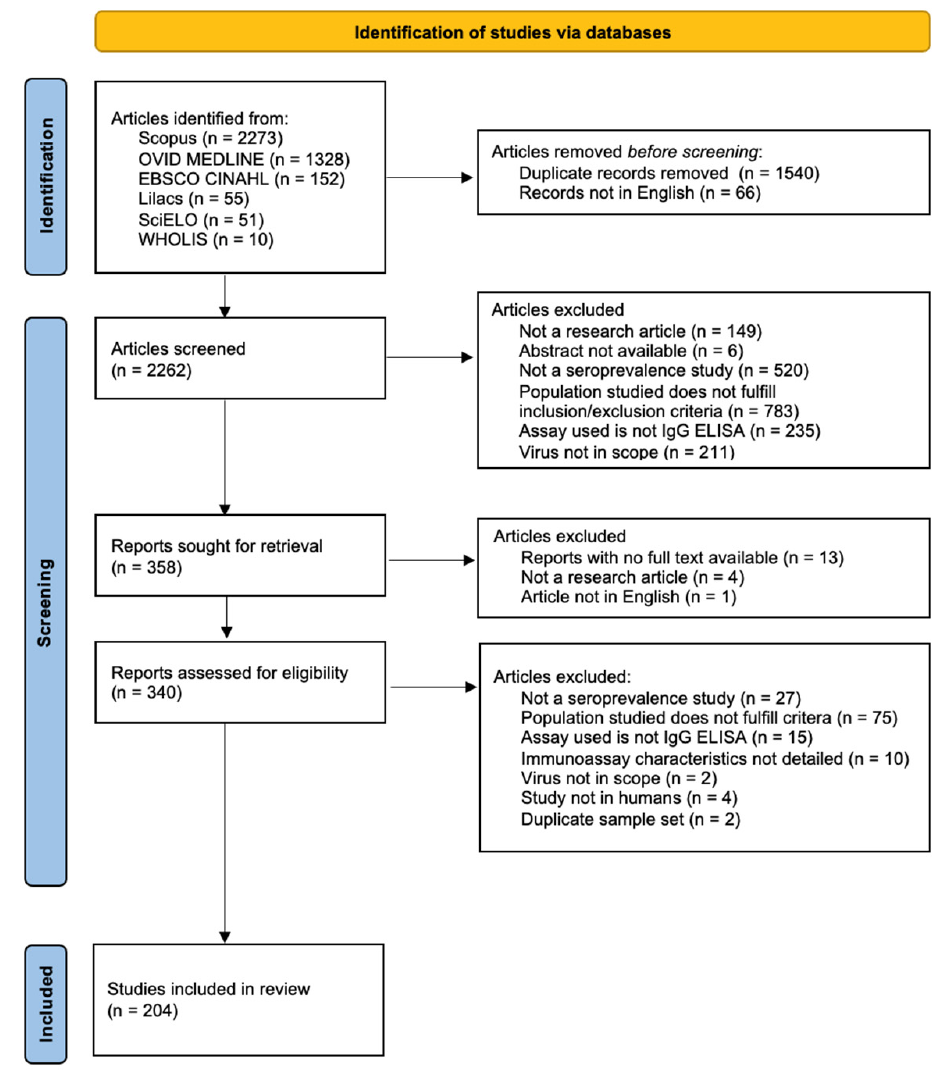
Figure 1. PRISMA flow diagram.